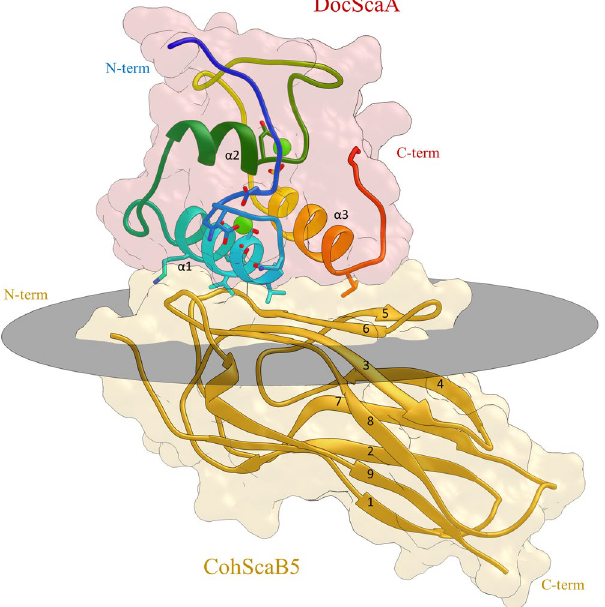
Figure 2. Structure of the Rf CohScaB5-DocScaA complex. Structure of the Rf CohScaB5-DocScaA complex with the dockerin in dark red and the cohesin in gold. The molecular surface of each module is represented in transparent colors. Under the transparent molecular surface and above the grey oval disk that marks the plane defined by the Coh 8–3–6–5 β -sheets, a ribbon representation shows the three Doc α -helices labeled α 1, α 2 and α 3. Below the grey oval disk a ribbon representation of the cohesin shows each of the 9 β -strands, labeled from 1 to 9. Ca 2 + ions are depicted as green